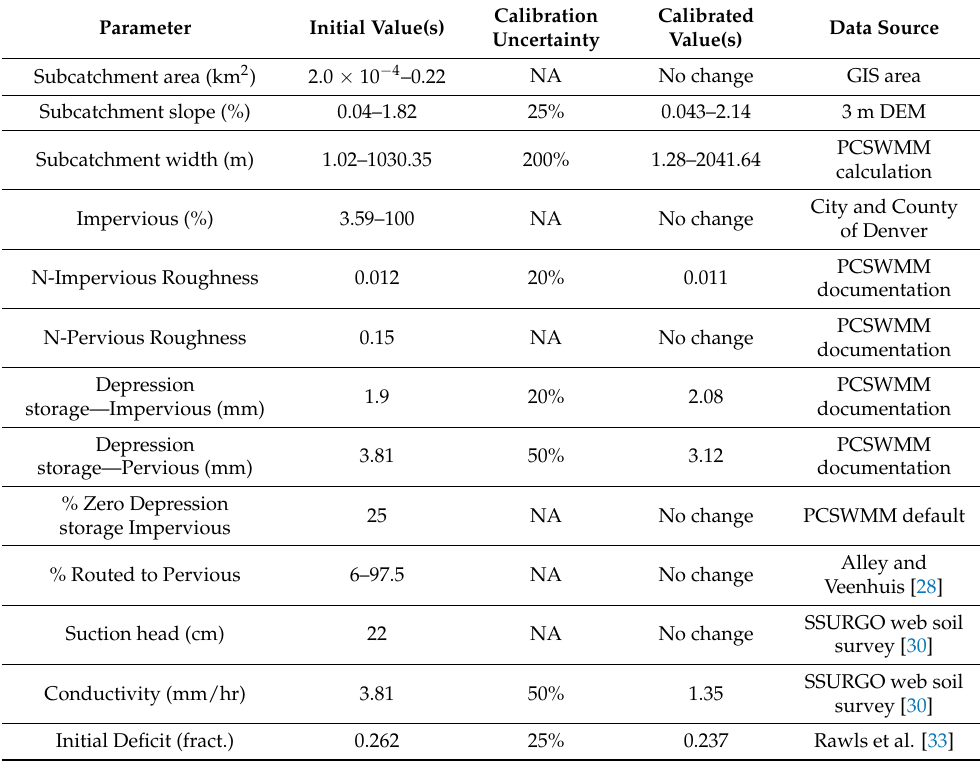
Table 1. Initial and calibrated PCSWMM parameters. Ranges are given for parameters that varied across